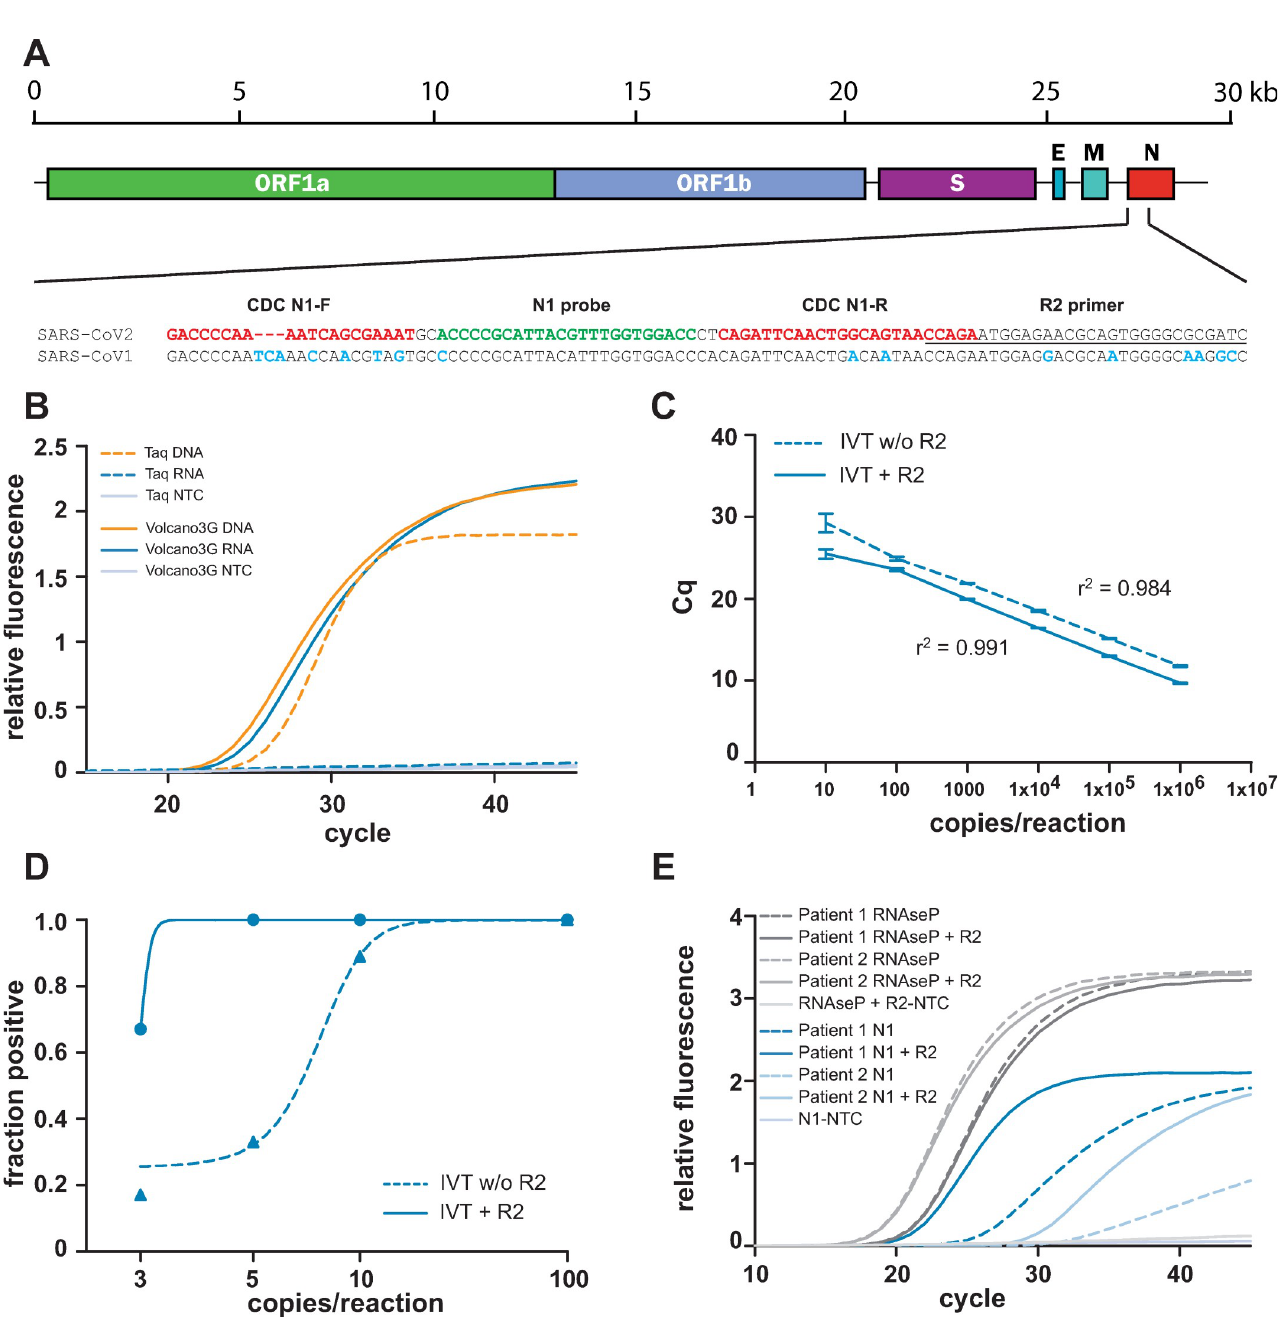
Fig 1. A RNA- and DNA-reading heat-stable polymerase reverse transcribes and amplifies viral RNA. A) Schematic overview of the SARS-CoV-2 genome. The target sequences for the N1 primers and probe are marked in red and green, respectively. The R2 primer binding sequence is underlined. Sequences divergence between SARS-CoV-2 and SARS-CoV-1 genomes are highlighted in blue. B) Performance of Volcano3G polymerase was compared to Taq polymerase using plasmid DNA or in vitro transcribed RNA as template (5000 viral genome equivalents). C) Determination of the linear dynamic range for the Volcano3G protocol with or without an additional primer (R2) for optimized reverse transcription at a final concentration of 250 nM. In vitro transcribed RNA containing the Sars-CoV-2 N amplicon was serially diluted in the range from 1x10 6 copies to 10 copies. D) Limit of detection (LOD) was assessed with serial dilutions ranging from 20 to 1 copy per reaction (n = 6 for each dilution). The fraction of positive reactions (y-axis) were plotted against the log-transformed number of RNA copies per reaction. Addition of R2 primer enhances the performance at lower copy-numbers. E) Amplification curves showing the performance of Volcano3G on isolated RNA from two COVID-19 patients in presence or absence of R2.